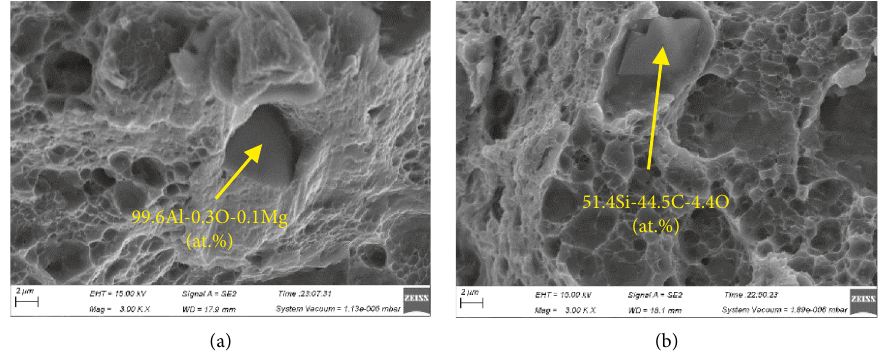
Figure 13: The fracture morphology of the composites: (a) without Sc; (b) with